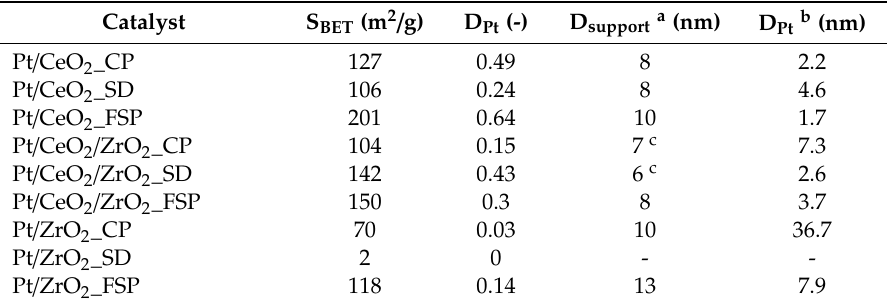
Table 1. Specific surface area, Pt dispersion, and crystallite sizes of the